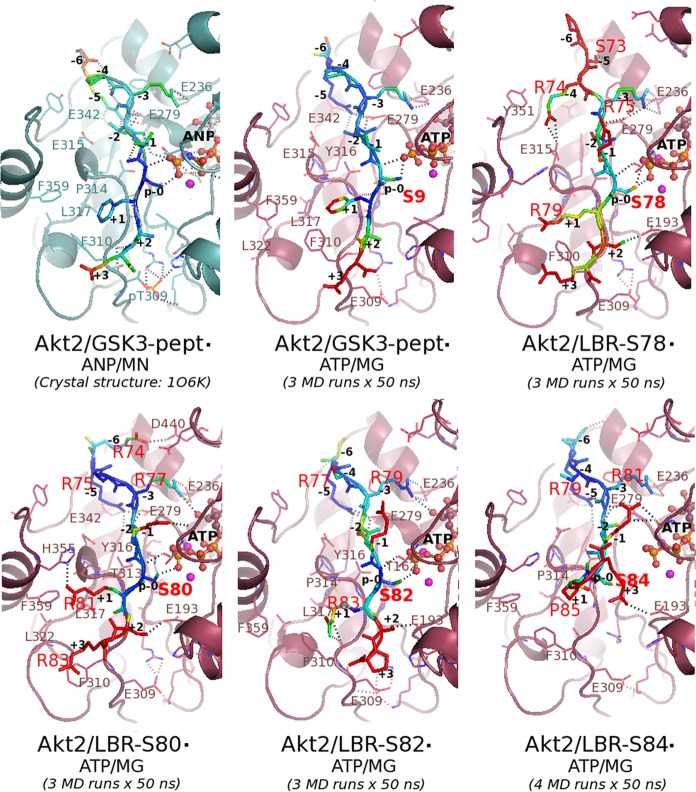
Atomic details of the interactions of LBR peptides with Akt2 in the simulated ternary complexes.Details of the interactions of the GSK3-β peptide with Akt2 in the template crystal structure and in the corresponding final 3D-model produced in this study are also shown. The bound peptides are depicted as stick models and are colored according to their atomic B-factors (see “Materials & Methods”): from blue to red for low to high B-factor values, respectively. Critical residues are labeled. Peptide positions are numbered according to the Akt consensus motif. The ANP and ATP molecules are depicted as balls-and-sticks. Magnesium (manganese in the crystal structure) atoms are shown as spheres, in magenta. H-bond interactions are depicted as broken lines. This figure was rendered using PyMOL.